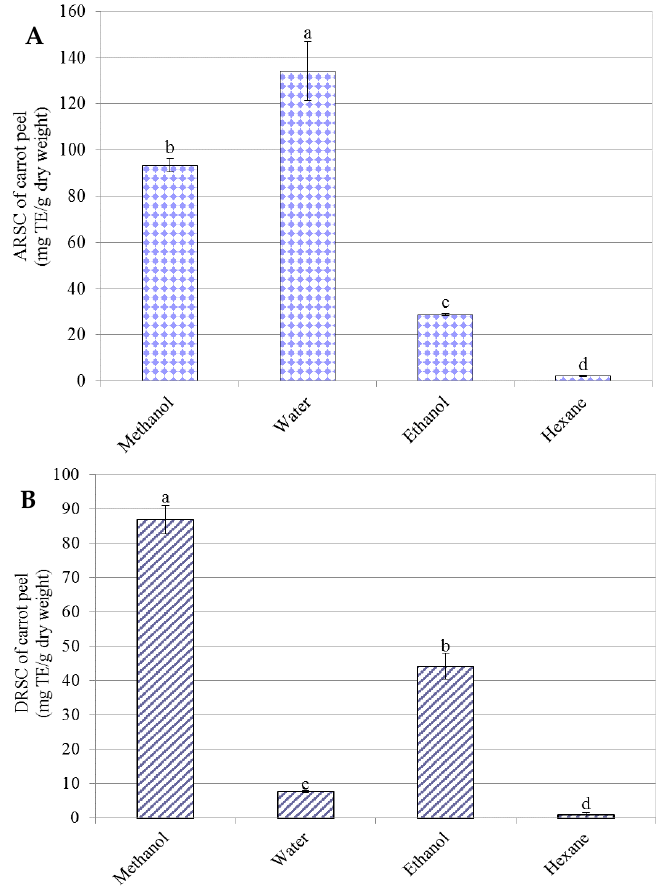
Figure 3. Antioxidant capacity of carrot peel extracted by four various solvents: ( A ) ABTS radical scavenging capacity and ( B ) DPPH radical scavenging capacity. Means and standard deviations were of triplicate. Different letters (a,b,c,d) within the columns denotes a significant difference between treatments ( p < 0.05).